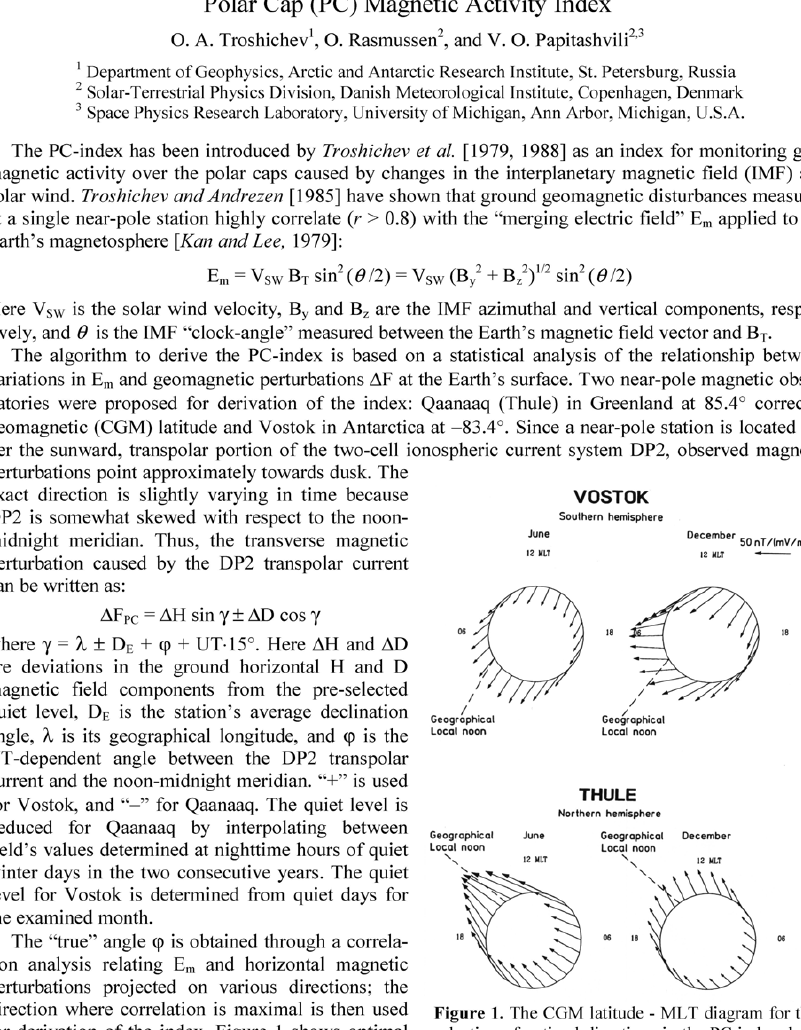
Fig. 6. The paper presented to IAGA that was later removed from circulation. Please note the PC index is still under review and thus has not been endorsed by